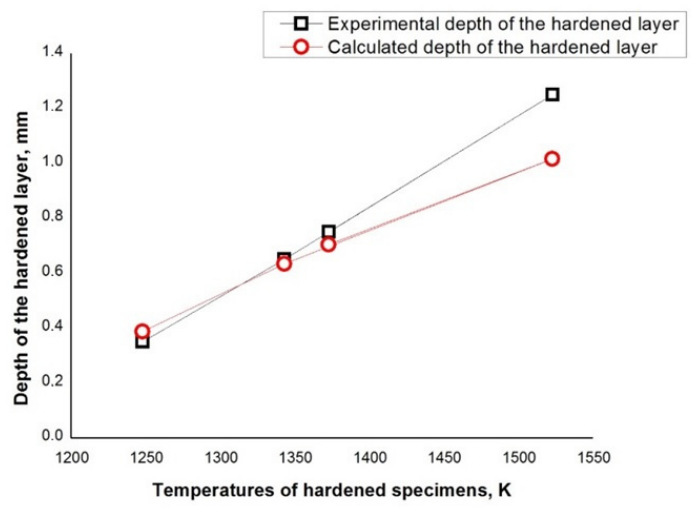
Figure 5. Dependence of the depth of the hardened zone on the surface temperature.